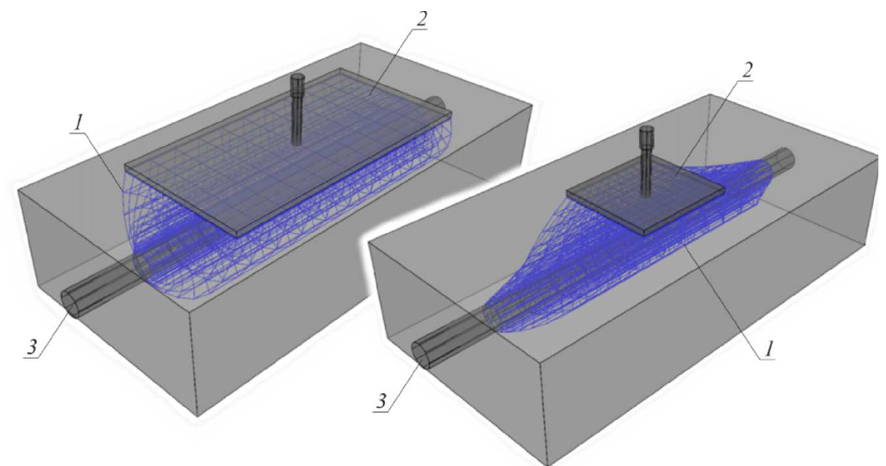
Figure A2. Comparison of the “flexible” grid of points representing electrically conductive area of concrete 1 under the alternating current polarization between the counter electrode 2 and the rebar 3; point grids shown in the figure were determined empirically from the Formulas (A1)–(A16).